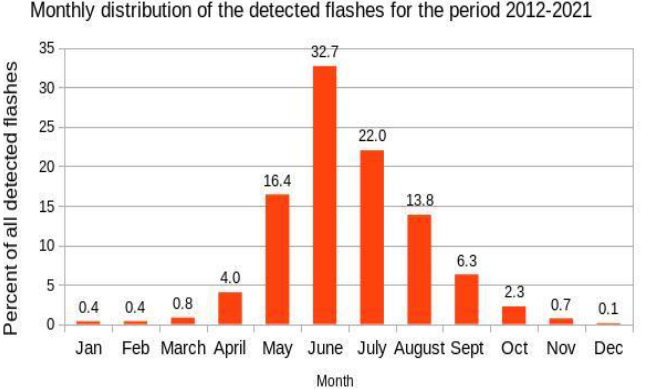
Figure 4. Monthly distribution of flashes detected by ATDnet over the studied domain for the period 2012 – 2021.